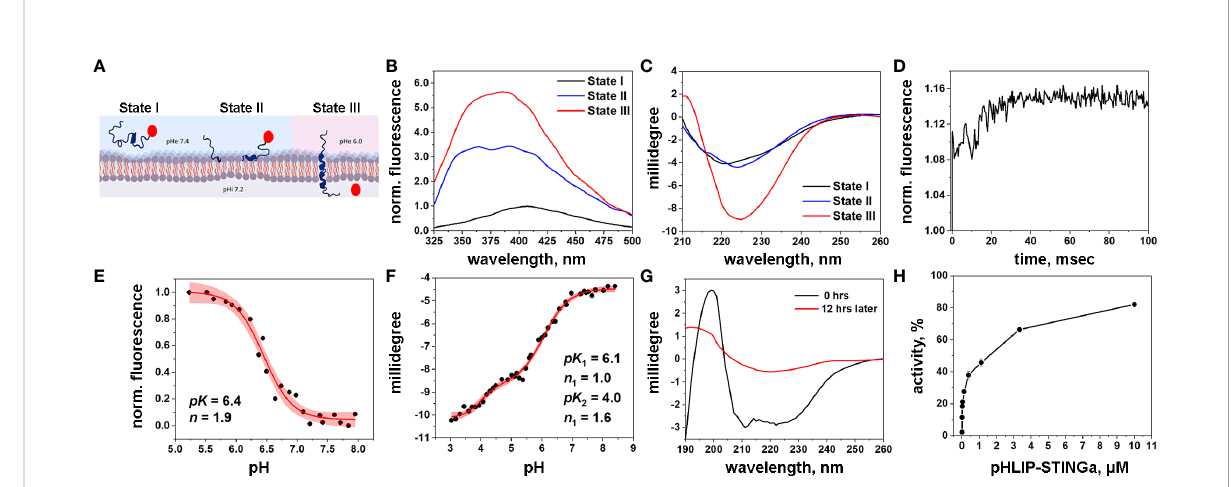
FIGURE 1 Characterization of pHLIP-STINGa (A) Schematic presentation of pHLIP-STINGa interaction with a membrane lipid bilayer (the pHLIP peptide is shown in dark blue and STINGa is shown by a red circle). In state I, pHLIP-STINGa forms an unstructured polymer in solution at normal pH. State II shows the interaction of pHLIP-STINGa with the membrane at normal pH. State III represents the transmembrane helical orientation of pHLIP triggered by low pH, which leads to the translocation of STINGa across the lipid bilayer and its release in the cytoplasm. The three states were monitored by changes of fl uorescence (B) and CD (C) spectral signals of pHLIP-STINGa interacting with POPC liposomes. (D) Kinetics of fl uorescence changes triggered by pH drop in presence of POPC liposomes is shown. pH transitions monitored by changes of fl uorescence intensity (E) and CD (F) spectral signals are shown (experimental points and fi tting curves, red, with 95% con fi dence interval, pink). (G) OCD spectra of pHLIP-STINGa recorded immediately after deposition of pHLIP-STINGa on the supported bilayer and 12 hrs later, when the insertion of pHLIP-STINGa into bilayer was complete, are shown. (H) Activation of the IFN signaling pathway induced by pHLIP-STINGa in THP1-Blue-ISG cells polarized by PMA, IL-4/IL-13 into M2-type macrophages is shown. The results were normalized to the activity of STINGa alone at the maximum concentration tested, which was taken as